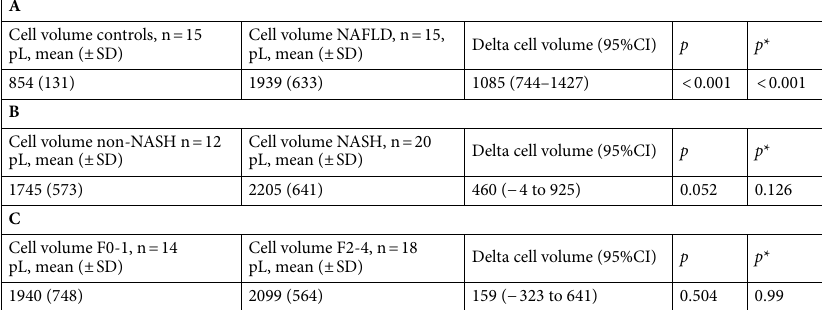
Table 2. Mean cell volume of adipocytes in A) 15 metabolically healthy controls matched on body mass index versus 15 subjects with NAFLD, B) NAFLD subjects without NASH versus subjects with NASH and, C) NAFLD subjects with low (F0-1) versus high (F2-4) stage of fibrosis. P * denotes significance for multiple linear regression adjusting for sex, body mass index and type 2 diabetes mellitus. P denotes significance for simple linear regression analysis.